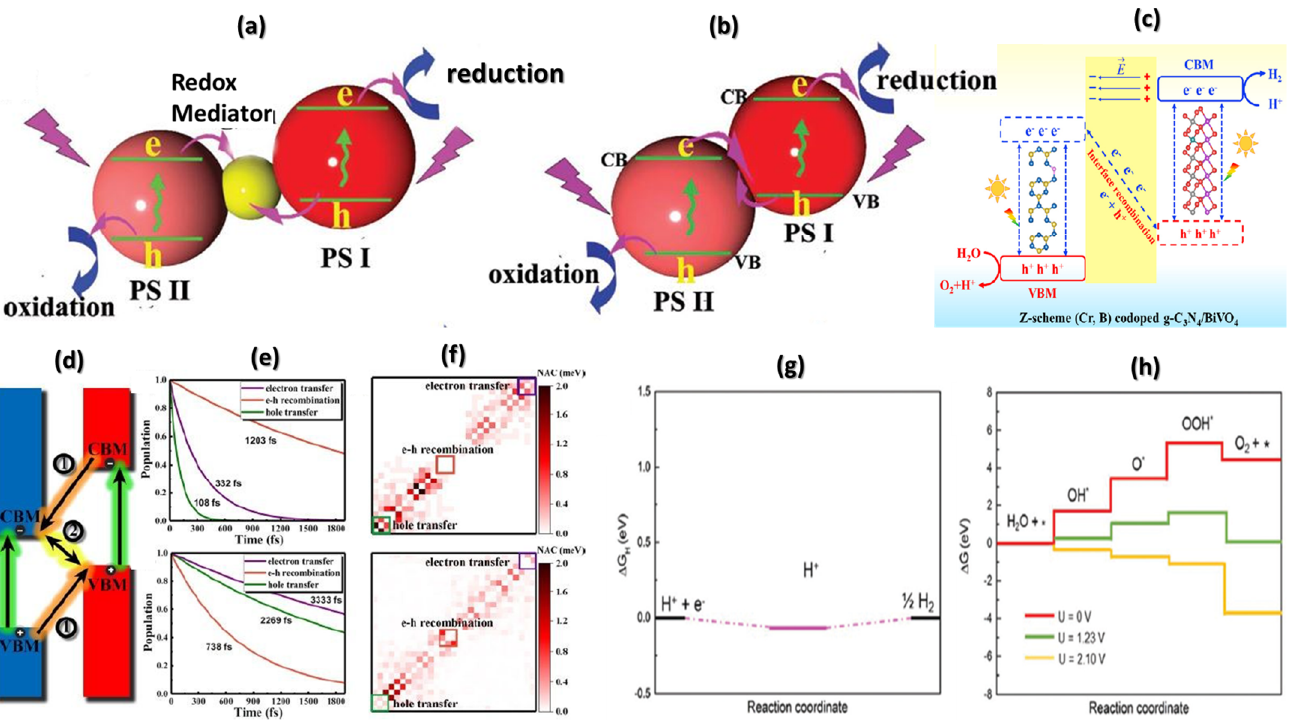
Figure 11. Schematic illustrations of ( a ) ideal Z-scheme system and ( b ) direct Z-scheme system. Reprinted with permission from ref. [226]. Copyright 2015 Wiley-VCH. ( c ) Schematic illustrations of the reaction mechanism for photocatalytic water-splitting and photocatalytic mechanism. Reprinted with permission from ref. [227]. Copyright 2020 Elsevier. ( d ) Schematic diagram of the photo-excitation and charge transfer dynamics at the MoSSe/WSeTe interface ( e ) The electron transfer, hole transfer, and e-h recombination dynamics of MoSSe/WSeTe heterostructure with Te-Se and Te-S stacking. ( f ) Averaged values of NAC between different states for Te-Se and Te-S stacking. Reprinted with permission from ref. [240]. Copyright 2019 RSC. ( g ) ∆ G H as a function of reaction coordinate on Are layer in the PtS 2 /Are vdW heterostructure. ( h ) The free energy diagram for OER on PtS 2 layer in the heterostructure at U = 0 V, 1.23 V, 2.10 V potential. Reprinted with permission from ref.